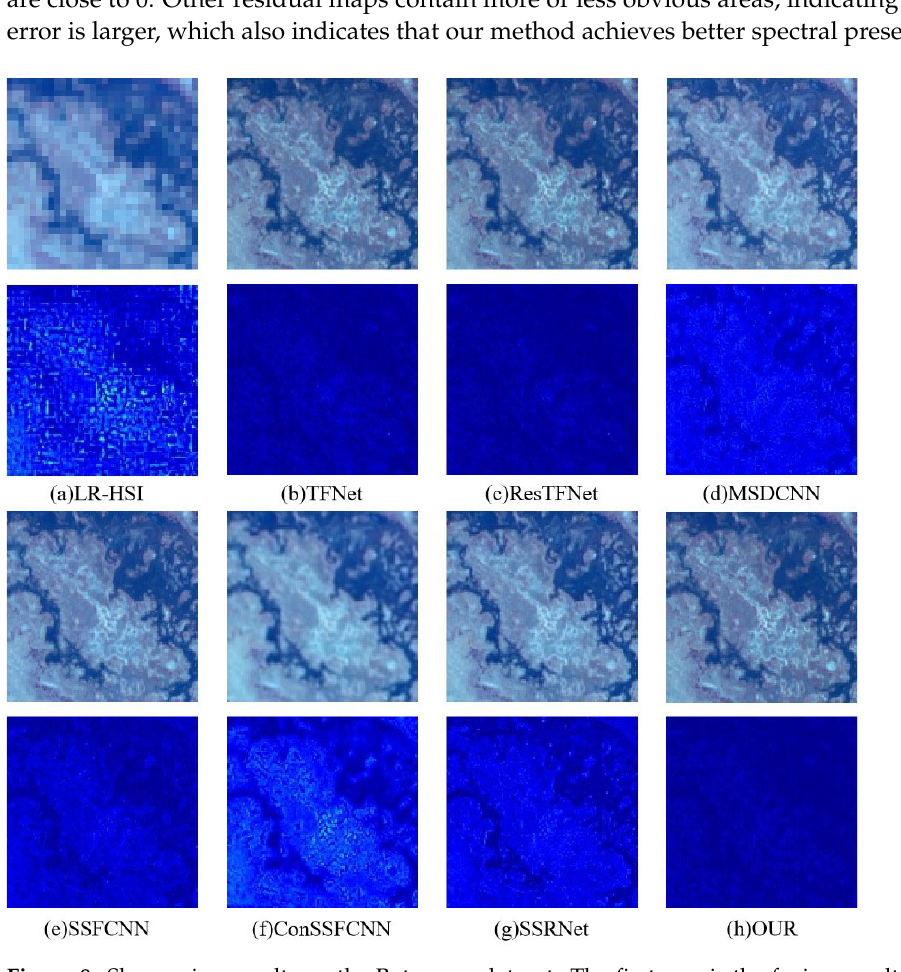
Figure 8. Sharpening results on the Botswana dataset. The first row is the fusion result, and the second row is an image obtained by pseudo-coloring the differences between the fusion result of the first row and the ground truth RGB image. All images are displayed in true color (red, green, and blue being the three